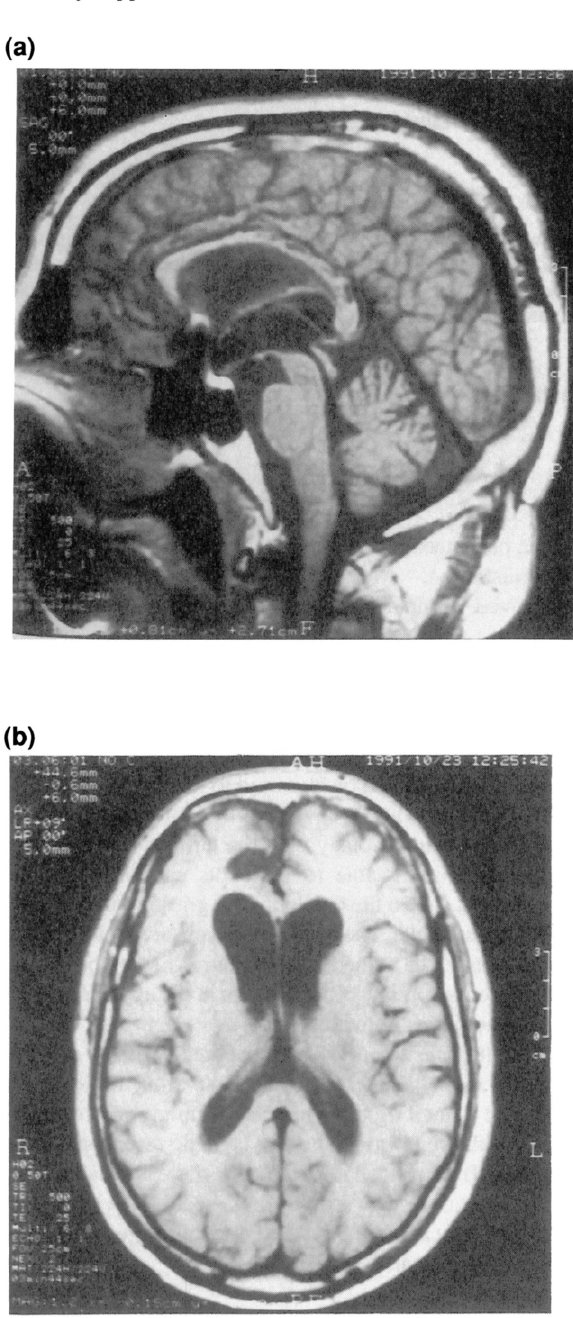
FIG. 1. MRI T1-weighted images showing (a) the corpus callosum infarct in sagittal plane and (b) the right medial frontal lesion in axial